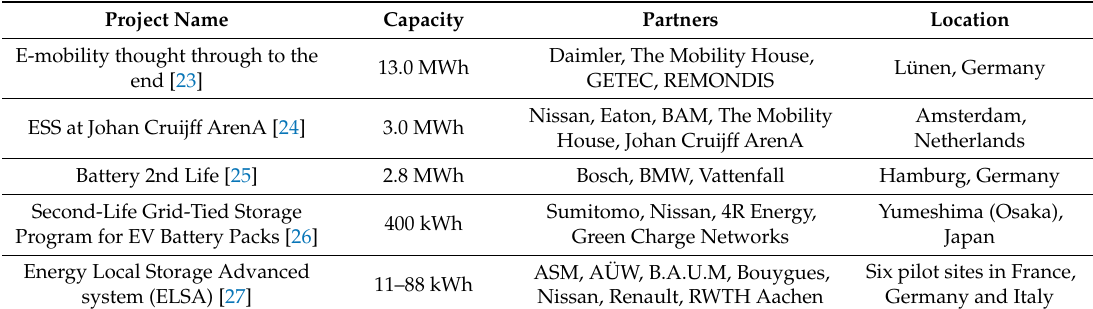
Table 1. Examples of projects for stationary energy storage with vehicle lithium ion batteries after their first life